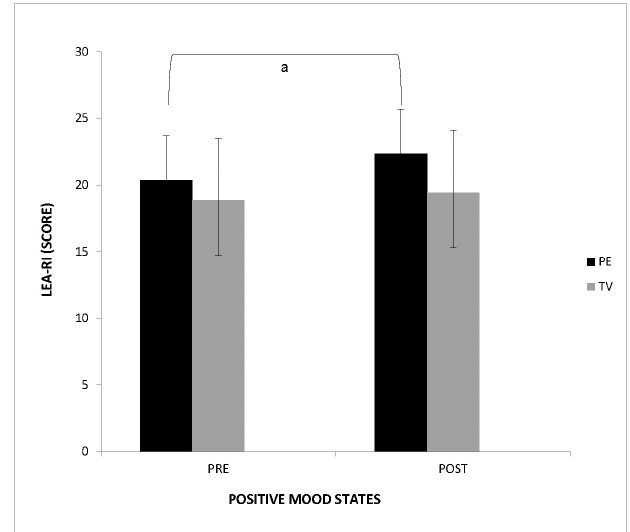
Figure 2. Mean and standard deviation of pre- and post-scores of positive mood states assessed using the Abbreviated and Illustrated Mood States Inventory (LEA-RI) between physical exercise (PE) and TV viewing conditions in older active women (n = 54, Rio Claro - SP, 2015, 2016); a paired sample t -test ( P < .05)